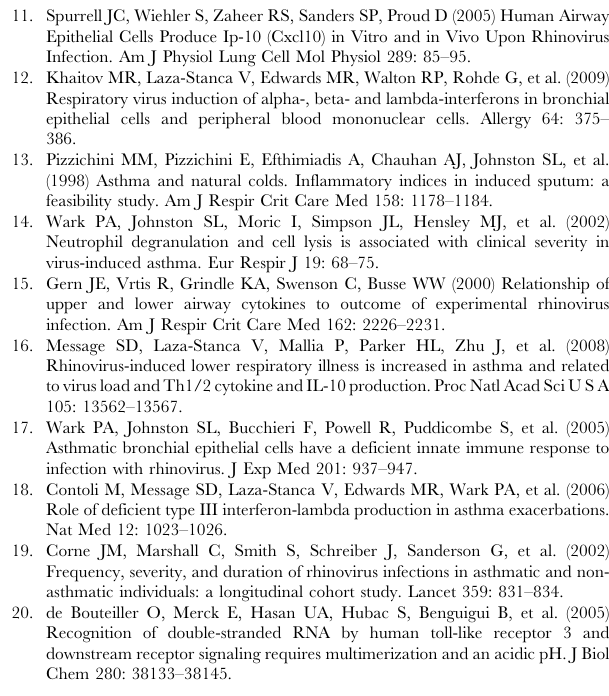
Figure S3 RIG-I mediates the anti-viral responses in RV infection in BEAS-2B cells. (A). Constitutively active RIG-I, ( D RIG-I) suppressed RV16 vRNA compared to pEF-BOS control at 24h post infection. (B). D RIG-I suppressed RV16 release compared to pEF-BOS control at 48h post infection. (C). D RIG-I suppressed RV1B vRNA compared to pEF-BOS control at 24h post infection. (D). D RIG-I suppressed RV16 release compared to pEF-BOS control at 48h post infection. * p , 0.05, ** p , 0.01, *** p , 0.001 as indicated n= 4-6 independent experiments. Figure S4 Proposed model of sequential involvement of TLR3/ TRIF and RIG-I/MDA5 in RV infecton. TLR3 and TRIF initially are involved in RV signalling in the recognition of RV infection and signal transduction within the endosome, and induce IFN- b , IFN- l and RIG-I and MDA5 early with the infection cycle (4-12h). After 12h, increases in RIG-I and MDA5 protein in the intracellular compartment recognise a concominant increase in intracellular RV dsRNA and ssRNA. This process induces robust IFN- b and IFN- l and possibly further RIG-I and MDA5 gene